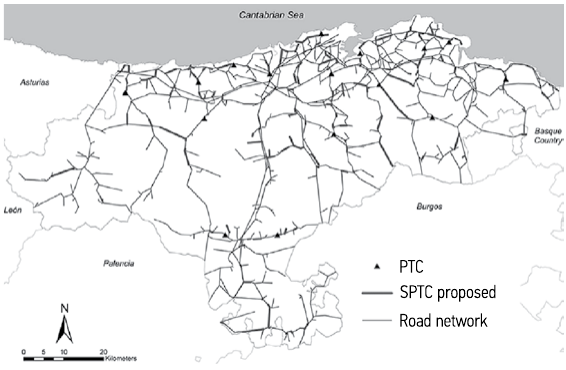
Fig. 9. Proposed location of counting